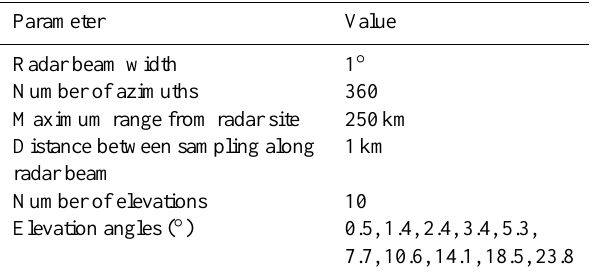
Table 1. Scan parameters currently used in the POLRAD weather radar network of IMGW-PIB. Parameter Value Radar beam width 1 ◦ Number of azimuths 360 Maximum range from radar site 250km Distance between sampling along 1km radar beam Number of elevations 10 Elevation angles ( ◦